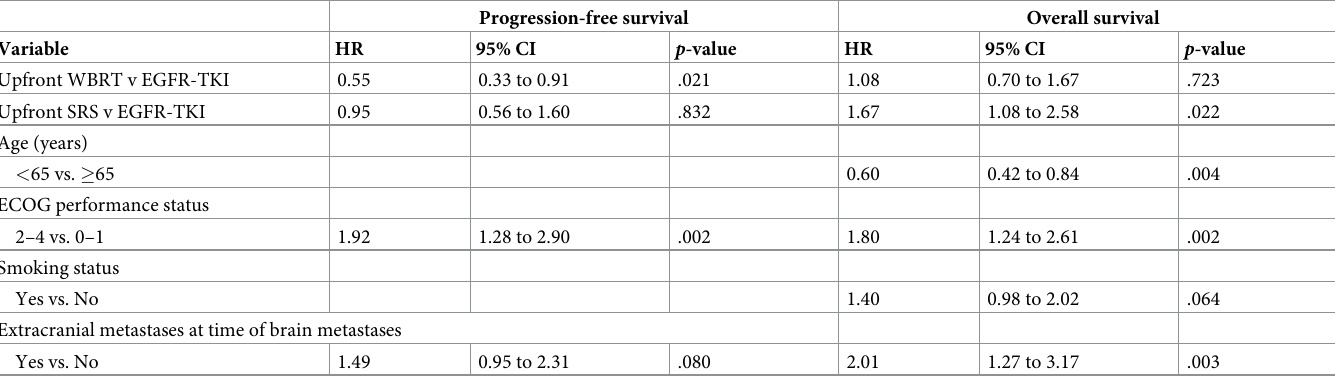
Table 3. Multivariable model of risk factors to predict intracranial progression-free survival and overall